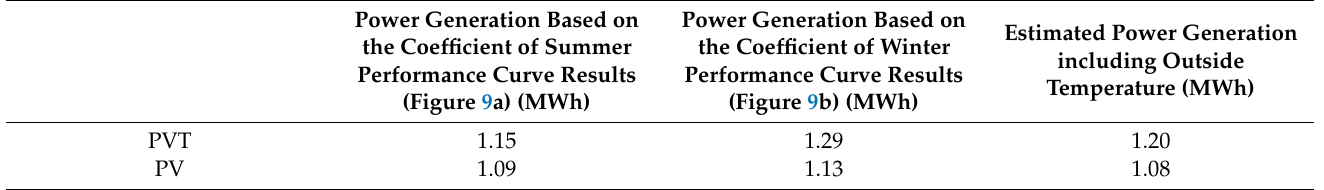
Table 4. Annual power generation forecast